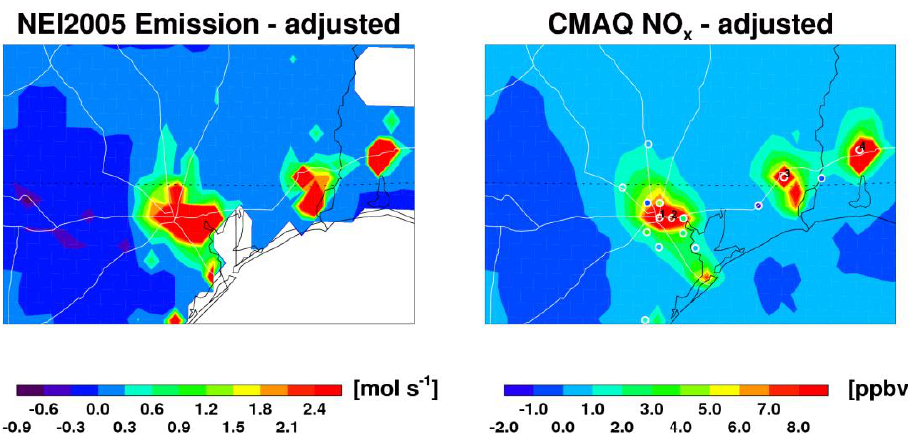
Fig. 7. The differences between surface NO x emissions of baseline emissions, BASE2009 and GOME-2-adjusted emissions, GOME2009 (left panel, the difference is estimated only when monthly NO 2 column averages are >10 15 moleculescm − 2 from GOME-2 and CMAQ over the continent); the differences between the surface NO x concentrations of the baseline CMAQ with BASE2009 and CMAQ with GOME2009 (right panel); and the differences between surface NO x concentrations of the baseline CMAQ with BASE2009 and EPA AQS observations (circles on the right panel) for the daytime (13:00–17:00LT) of August of 2009. Among the circled stations, the four marked stations (1: Houston A, 2: Houston B, 3: Beaumont, and 4: Sulphur) include the large discrepancies of >10ppbv NO x (baseline CMAQ simulations – EPA AQS